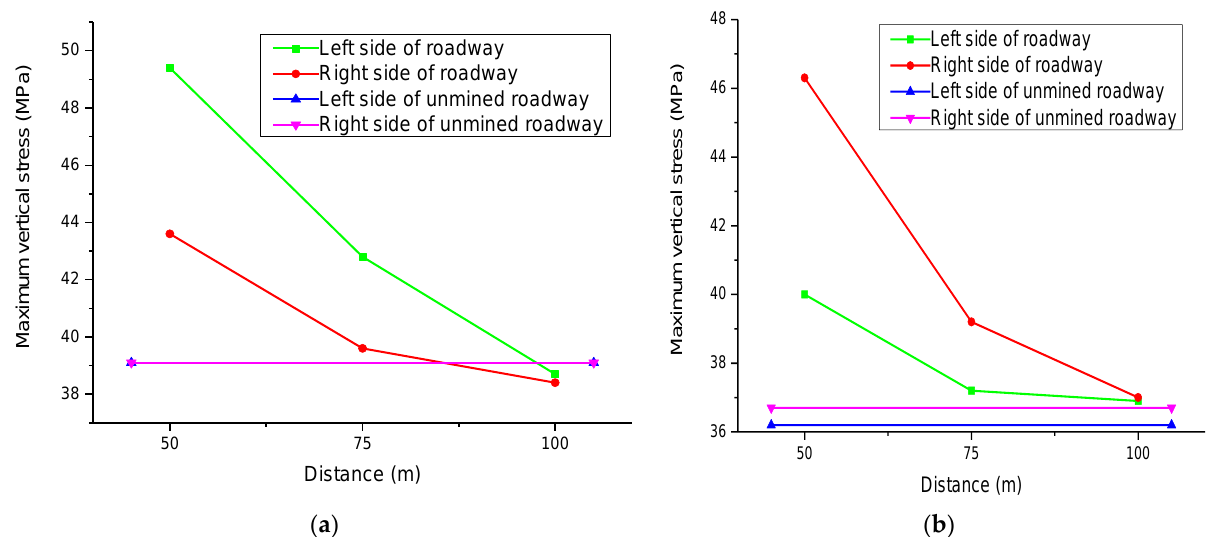
Figure 13. Maximum vertical stress at different distances between working face and roadway: ( a ) the track roadway and ( b ) the auxiliary transportation roadway.